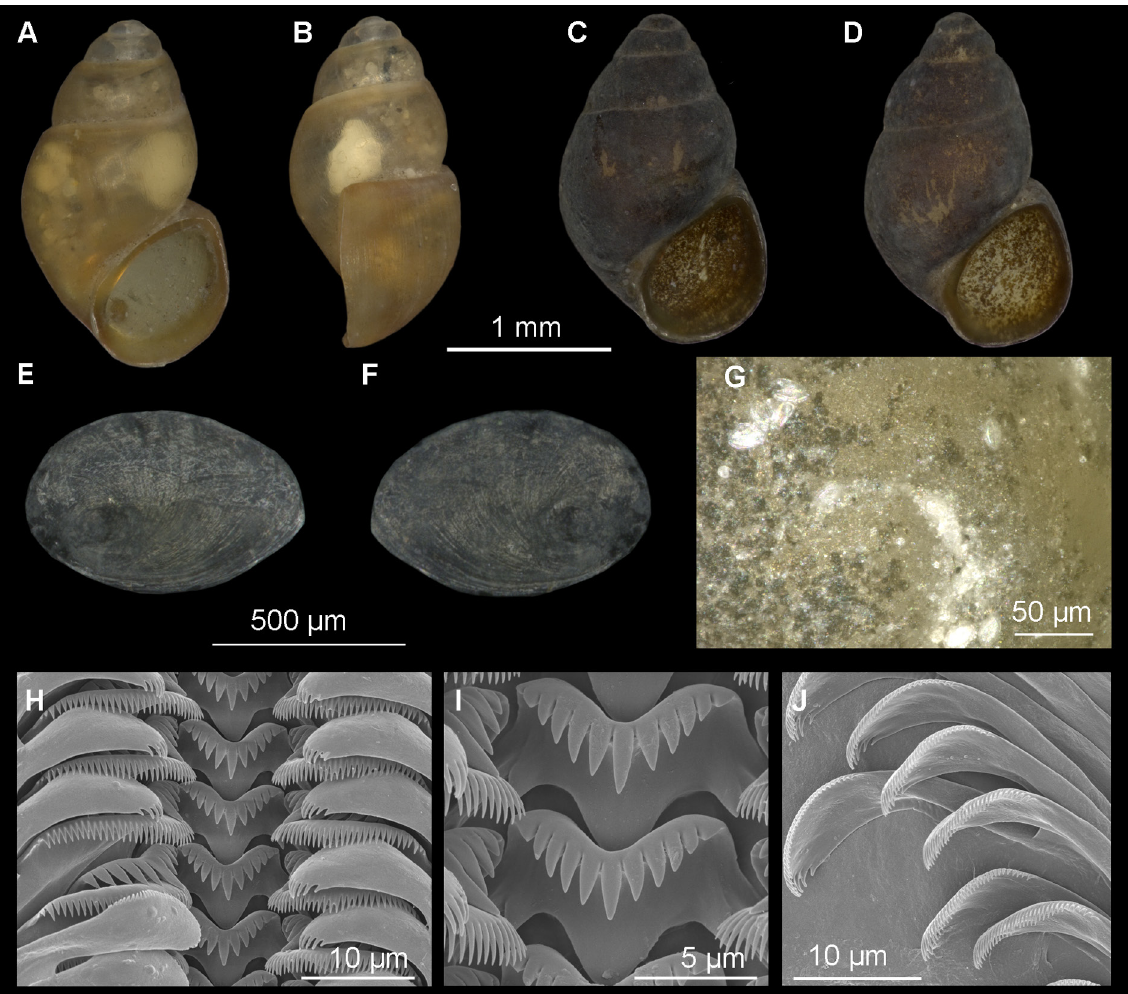
Fig. 5. Shells, opercula and radulae, Belgrandiellopsis secunda gen. et sp. nov. A–D . Shells. A–B . Holotype, MNCN 15.05/200098H. C–D . Paratypes, MNCN 15.05/200098P. E–F . Operculum (E = inner side; F = outer side). G . Detailed microsculpture of protoconch. H–J . Radulae. H . Portion of radula ribbon. I . Central radular teeth. J . Outer marginal